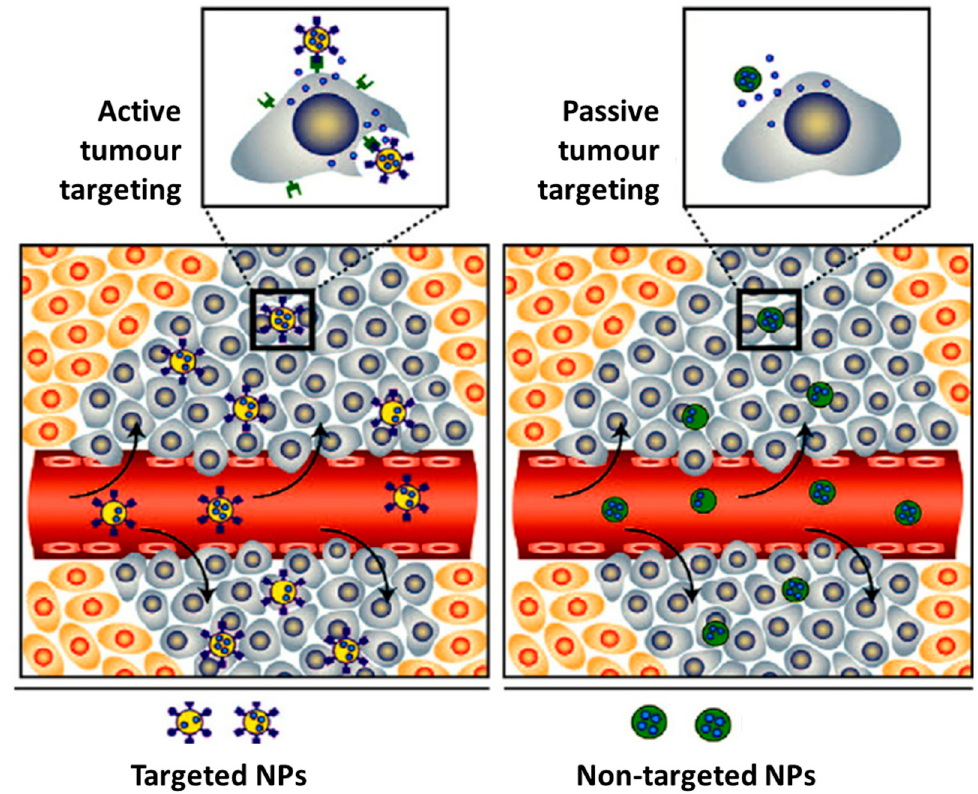
Figure 1. Illustration of the accumulation of nanoparticles in tumour tissues: passive vs active targeting. Adapted from Mahmoudi et al. (2011) [18].